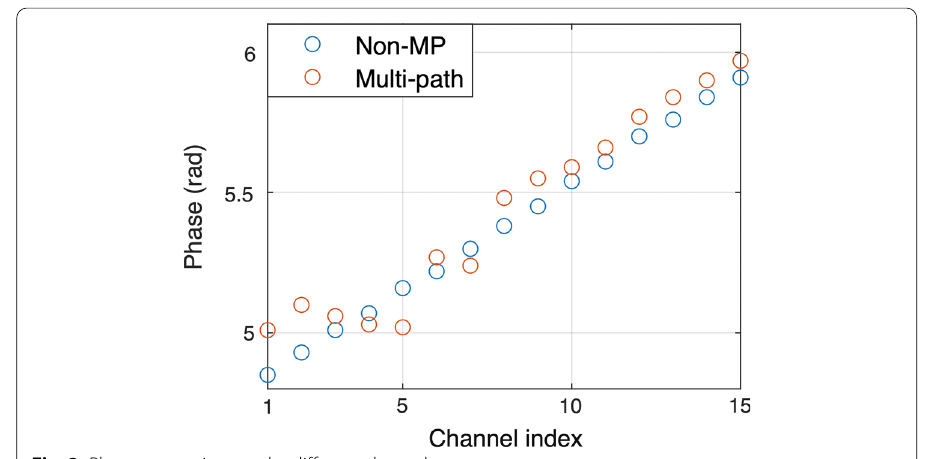
Fig. 2 Phase comparison under different